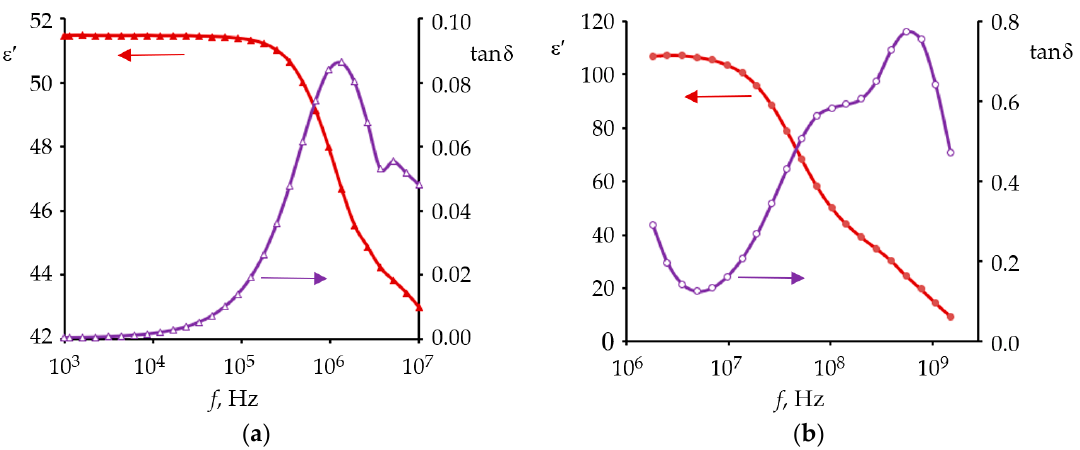
Figure 5. The frequency dependences of the dielectric constant ε′ and tan δ measured at room temperature for composite coatings PZTNB-1/PBO, heat-treated at 250 °C ( a ) and 300 °C ( b ).